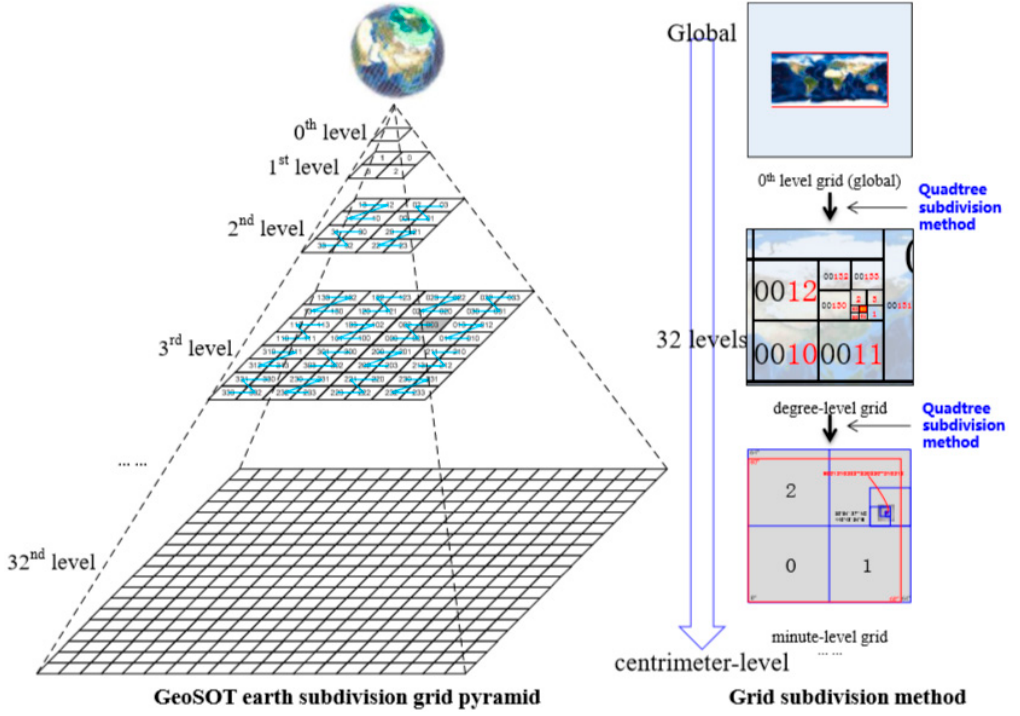
Figure 2. The binary one-dimensional encoding rule of GeoSOT [14].